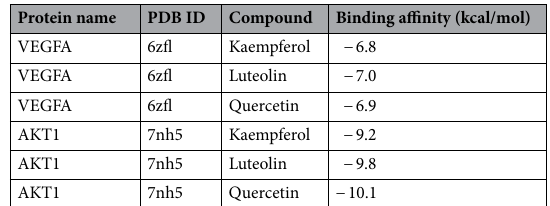
Table 1. Interaction energy results obtained by AutoDock